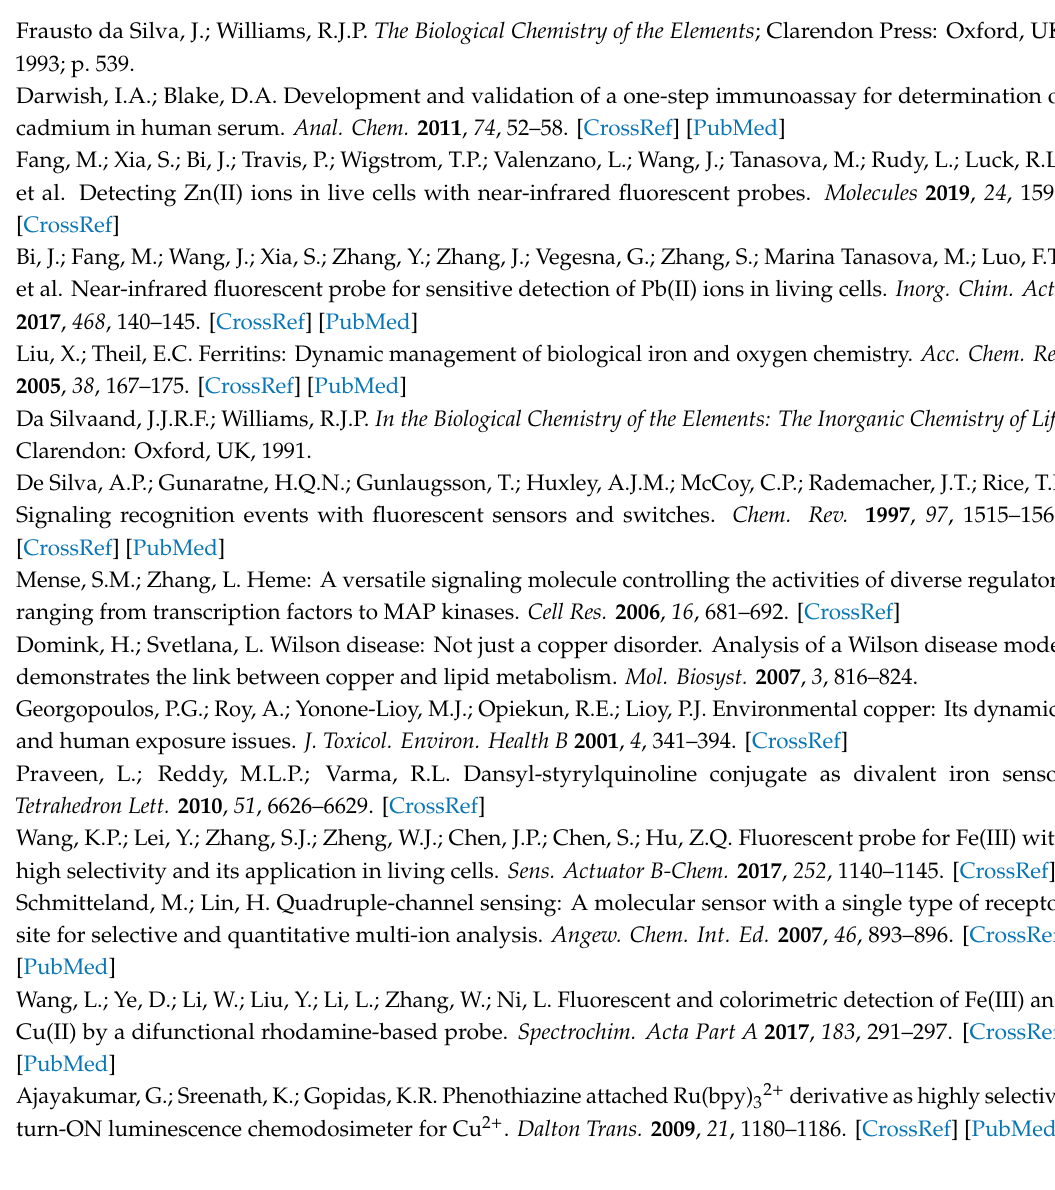
small amount of CDCl 3 ), Figure S3: 1 H-NMR spectrum for H 2 L (in DMSO- d 6 and a small amount of CDCl 3 ). Figure S4: 1 H-NMR spectrum for [{Ru(bpy) 2 } 2 ( µ 2 -H 2 L)](PF 6 ) 4 (in DMSO- d 6 ), Figure S5: 13 C-NMR spectrum for